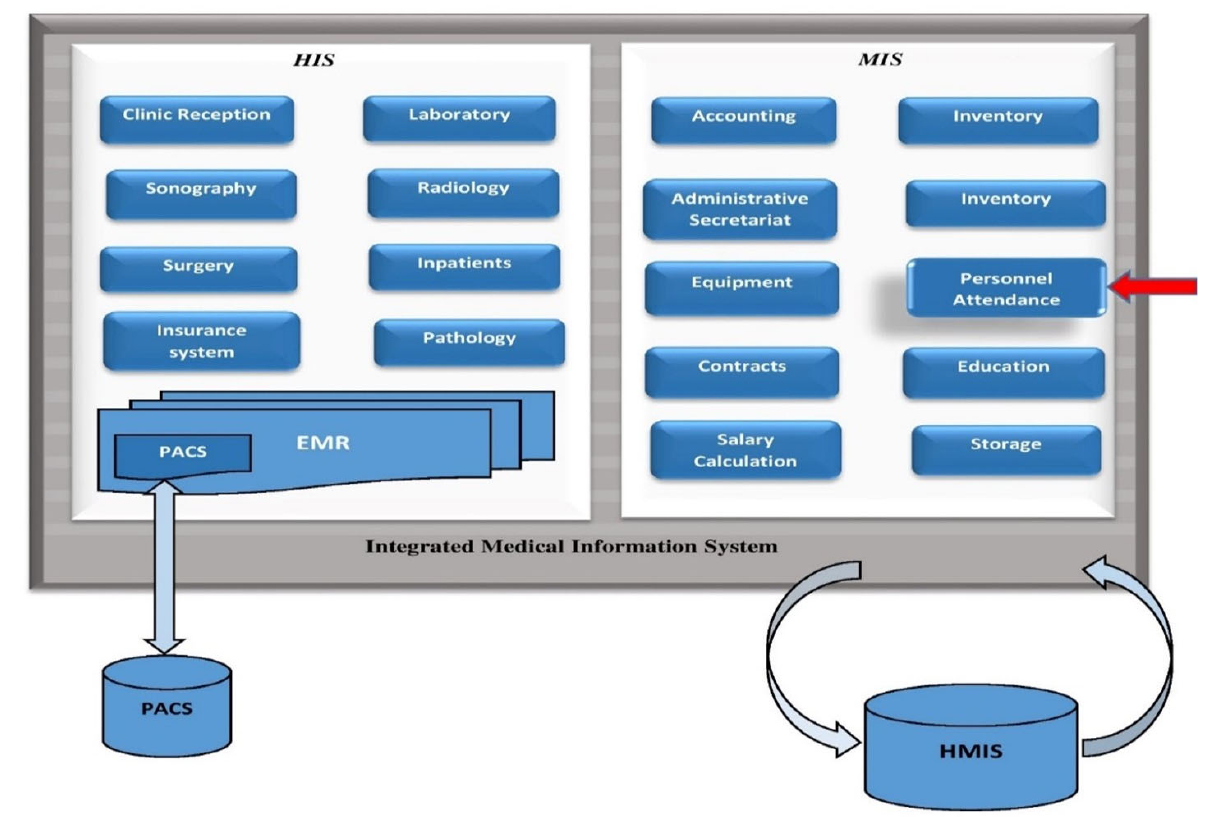
Figure 3. HMIS (HIS + MIS). Red pointer highlights the recently inserted personnel attendance sub-system